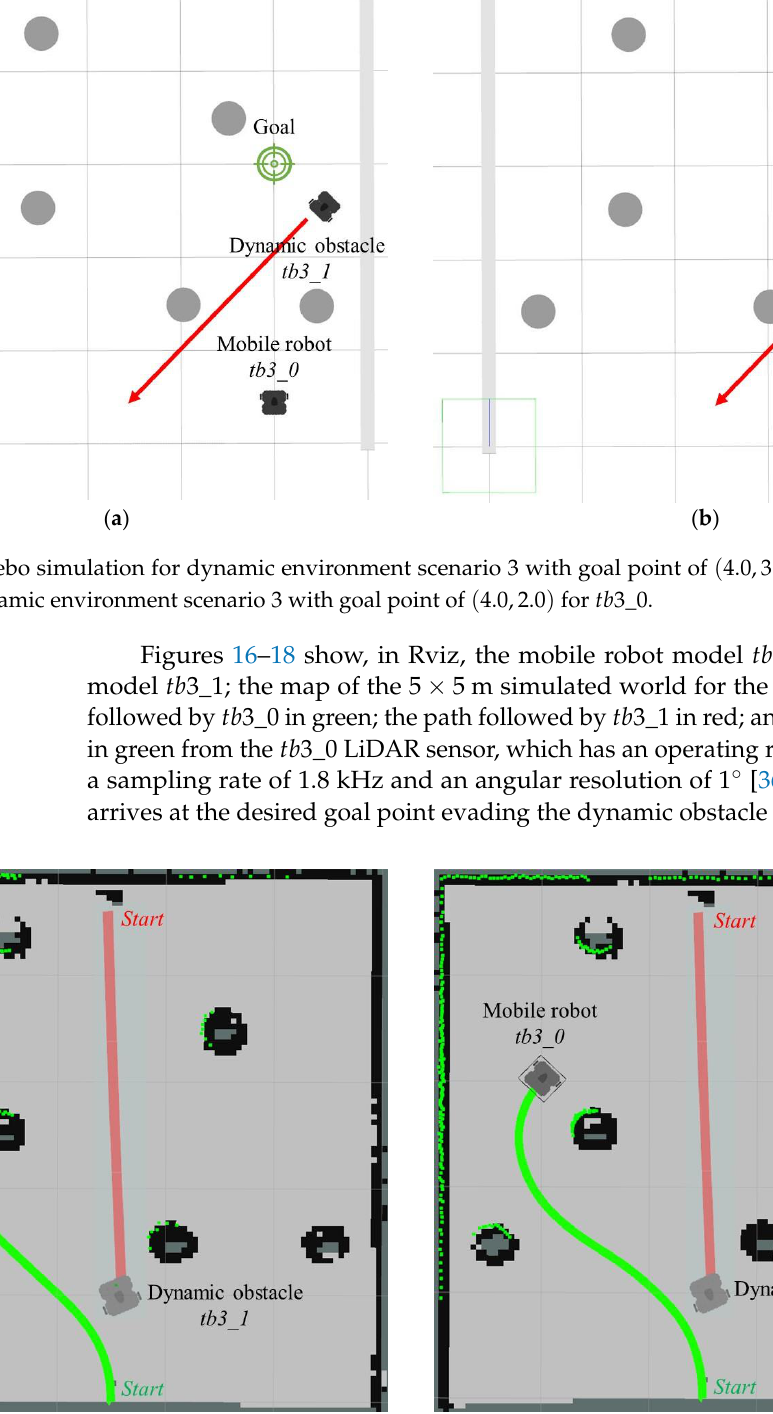
Figure 14. ( a ) Gazebo simulation for dynamic environment scenario 2 with goal point of (3.0,4.0) for 𝑡𝑏3_0 , ( b ) Gazebo simulation for dynamic environment scenario 2 with goal point of (3.0,3.0) for 𝑡𝑏3_0 .